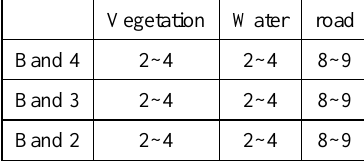
Table 1. Ranges of object classes in site 1 Table 2. Ranges of object classes in site